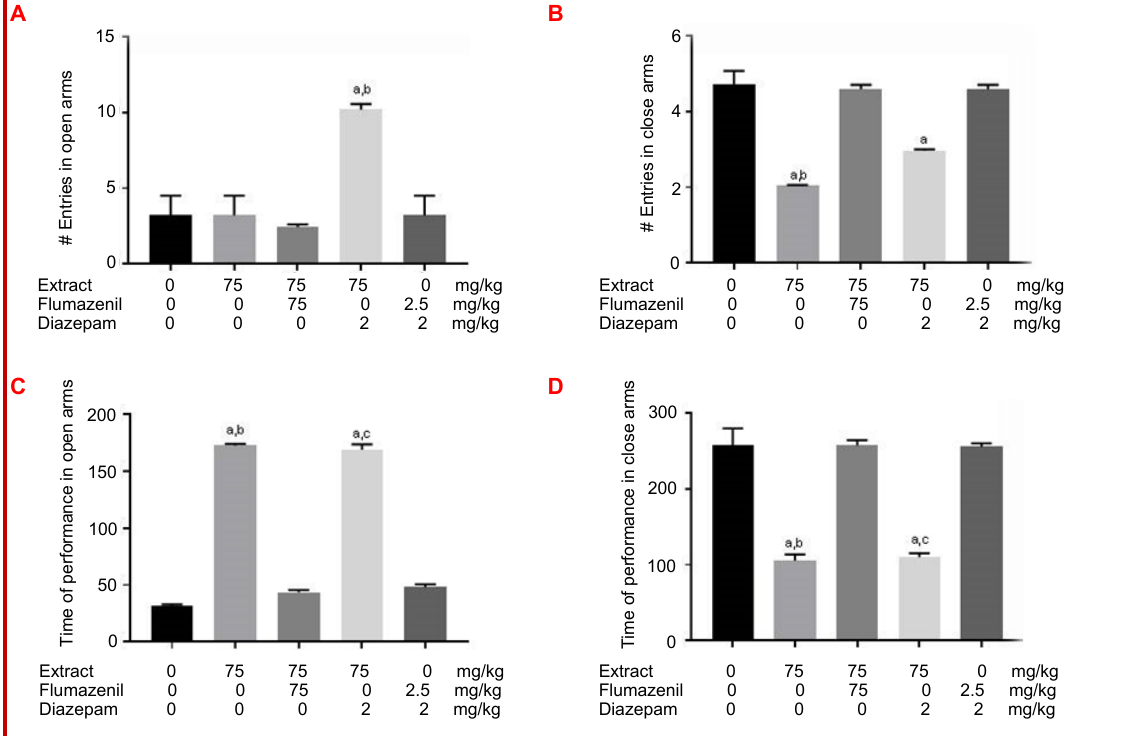
Figure 2: Effect of Euphorbia resinifera , diazepam and flumazenil in the EPM test (n=6 per group) values are expressed as mean ± SEM, where superscript ‘a’, ‘b’ and ‘c’ indicate p<0.05, statistically significant difference groups. One -way ANOVA followed by